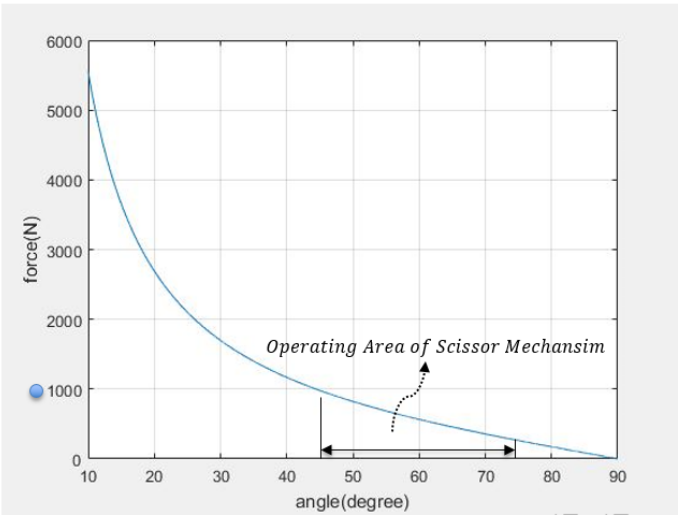
Figure 6. The required F 1 value for scissor static state by θ s . If scissor mechanism drive on operation area, scissor mechanism use the force lower than 1000 N (blue point) for supporting 100 kg